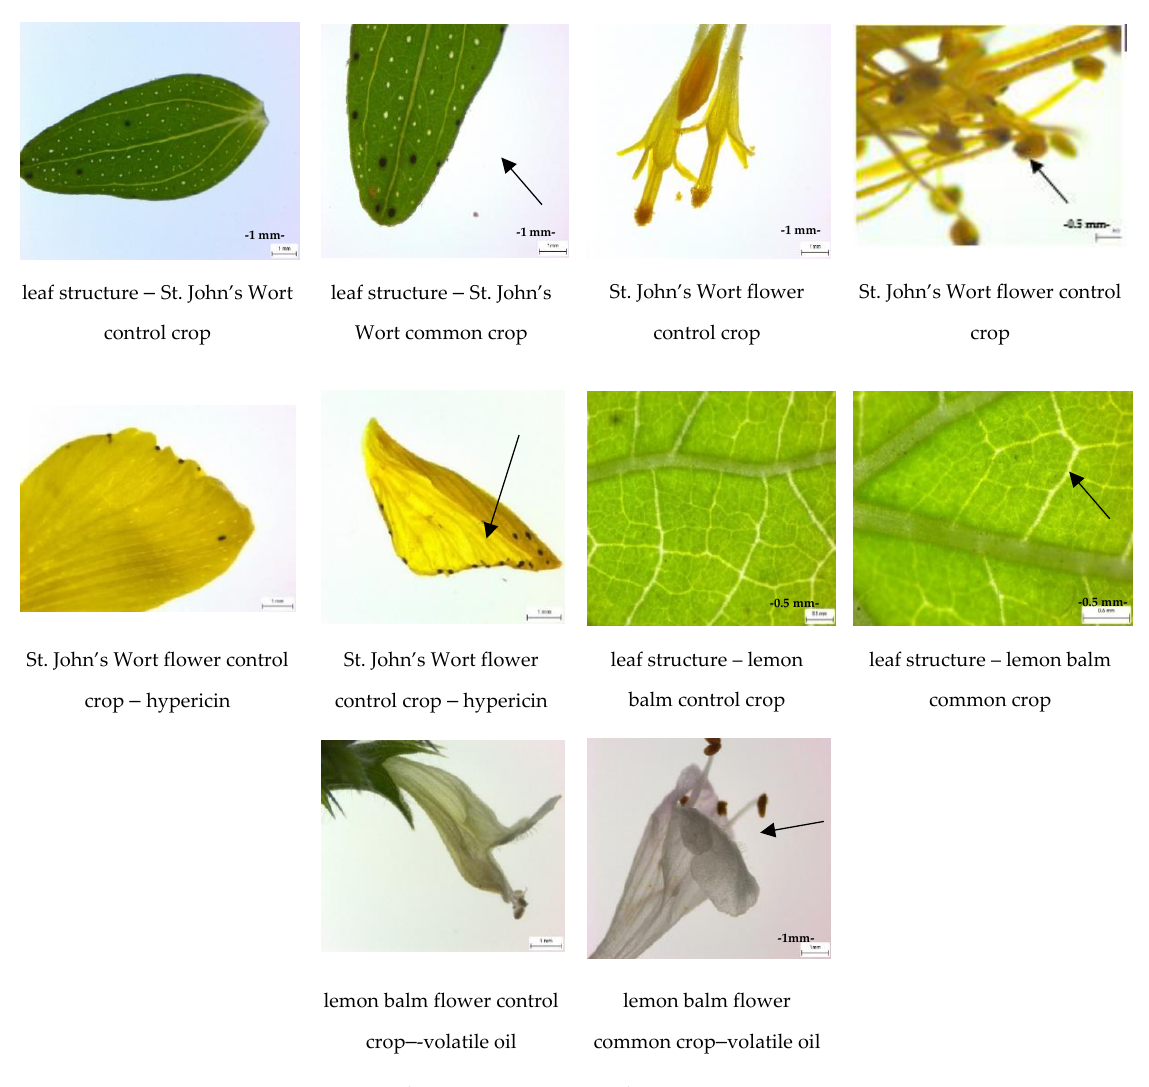
Figure 13. St. John ’ s Wort — Lemon Balm. Figure 13. St. John’s Wort—Lemon